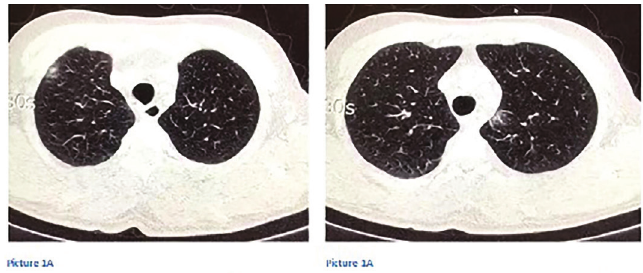
Figure 1 - In the right lung lobe anterior segment periphery, the lesion consistent with the halo finding and in the left lobe upper lobe, the ground glass opacities adjacent to the posterior section of the arcus